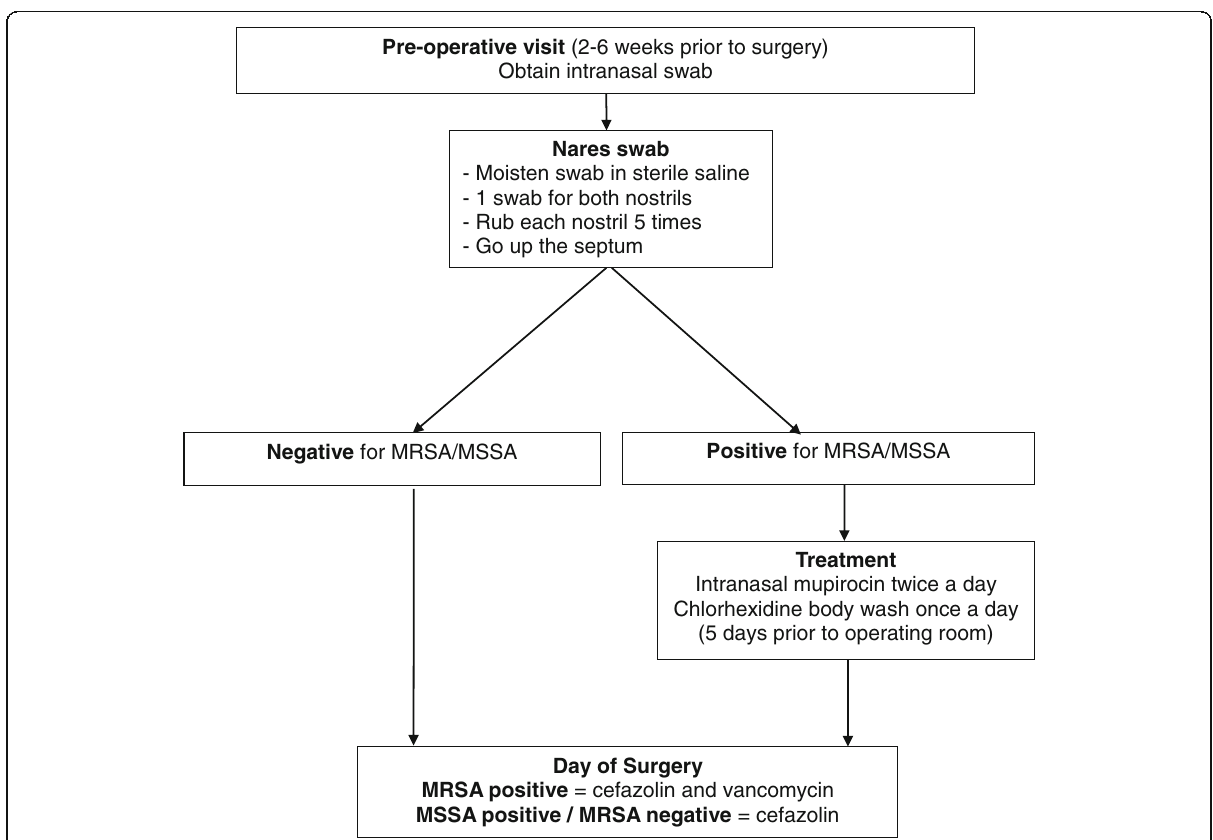
Fig. 1 Methicillin sensitive and resistant Staphylococcus aureus screening